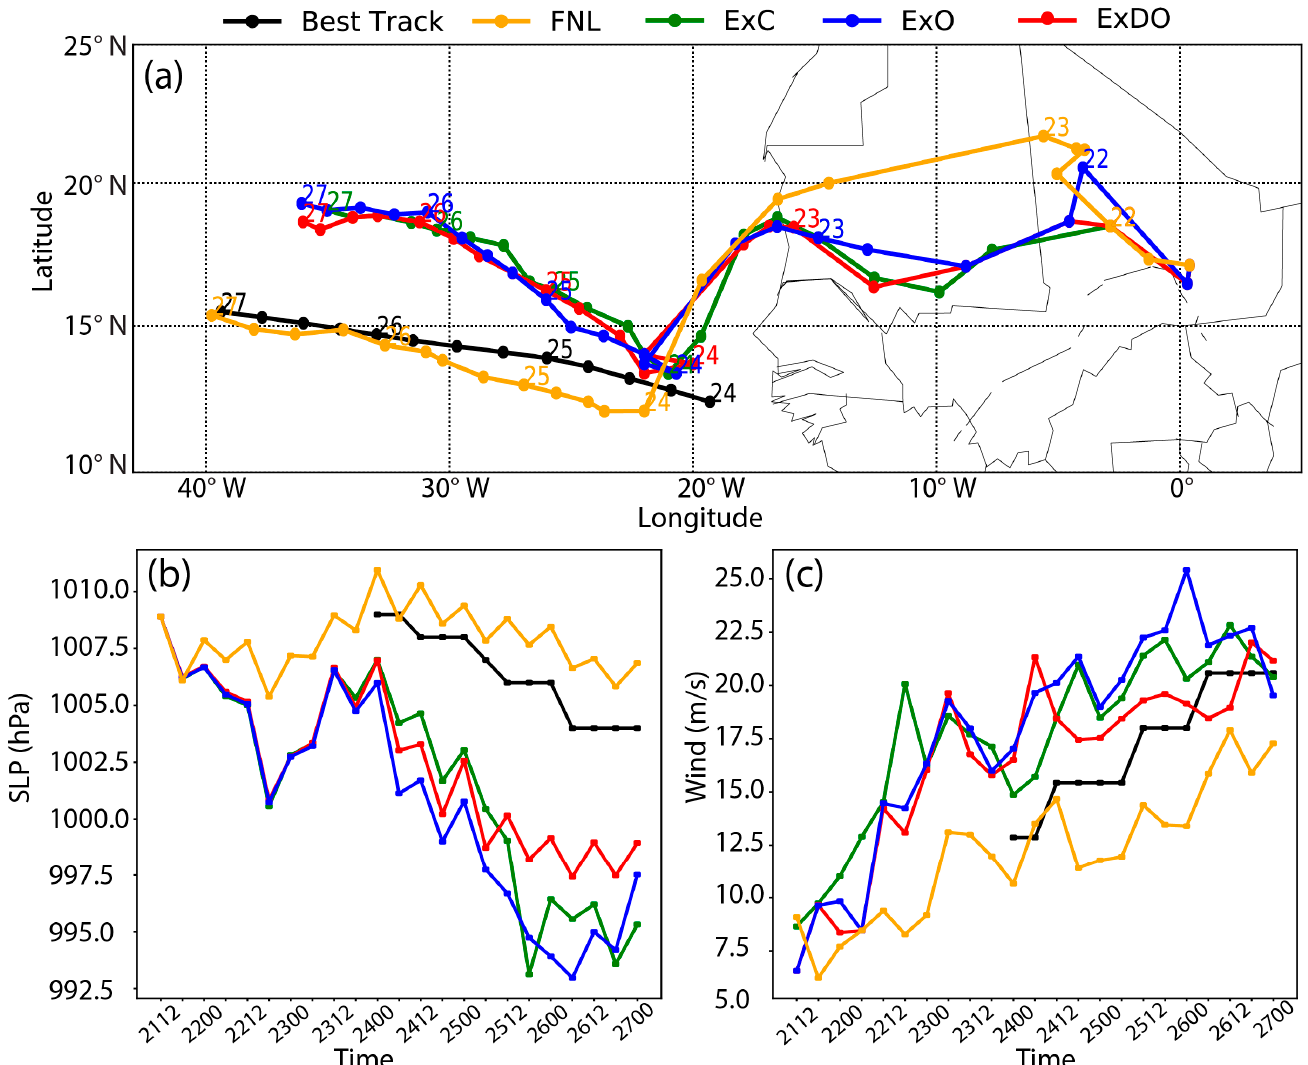
Figure 3. ( a ) The tracks, ( b ) the minimum sea-level pressure (hPa), and ( c ) the maximum surface wind speed (m/s) of the convective system (including low-pressure system over Africa and tropical cyclone over the ocean) from the simulations (ExC, ExO, ExDO), FNL, and the best track dataset. The numbers nearby the tracks in ( a ) indicate the corresponding dates of the positions of the systems in August 2010. The labels on the x -axis in ( b ) and ( c ) indicate the times. For example, 2112 means 1200 UTC 21 August 2010. The time interval is 6 h.